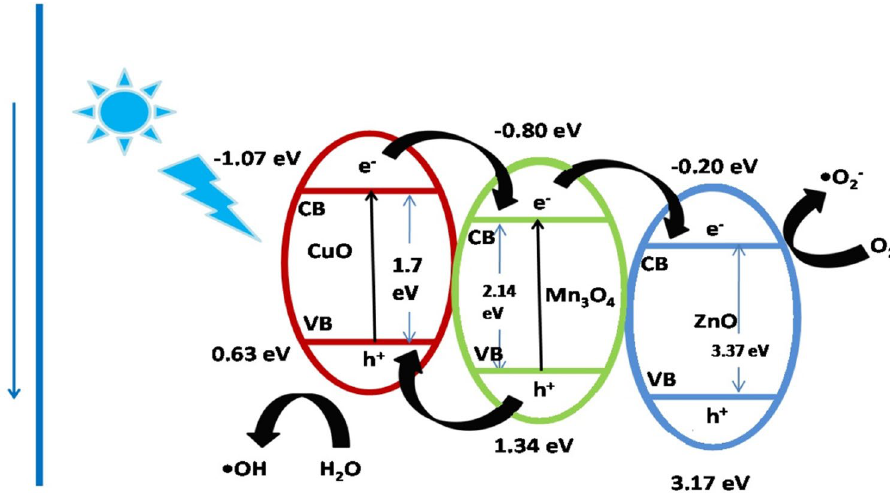
Figure 12. Schematic depiction of the tentative degradation mechanism by the integrated photocatalyst system.